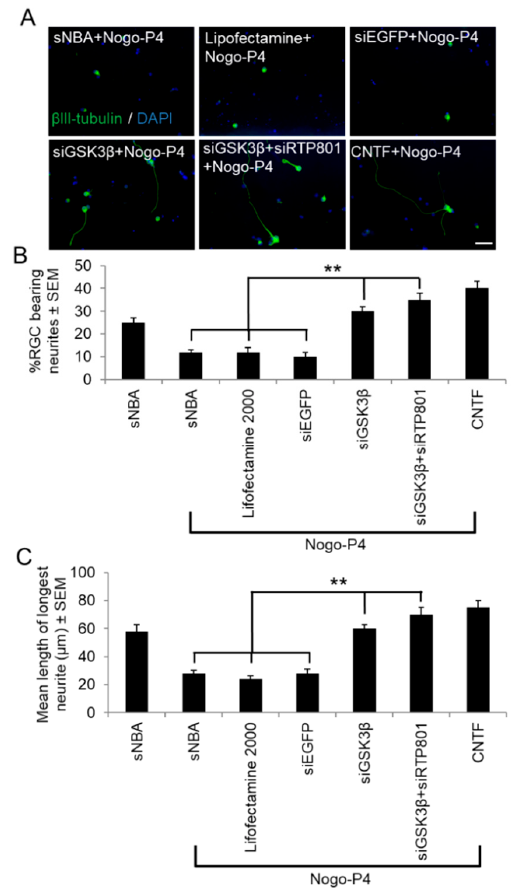
Figure 6. Inhibition of GSK3 β activity promotes disinhibition of RGC neurite outgrowth in the presence of inhibitory Nogo-P4 peptide. ( A ) Immunocytochemistry showing disinhibited neurite outgrowth from β III-tubulin + RGC in the presence of Nogo-P4 peptide after treatment with siGSK3 β whilst control cultures treated with sNBA, Lipofectamine 2000, or siEGFP were unable to achieve disinhibited neurite outgrowth. CNTF-treated cultures were used as positive controls. ( B ) Quantification of the proportion of RGC bearing neurites and ( C ) the mean longest RGC neurite after siRNA treatment in the presence of Nogo-P4 peptide, showing significant disinhibition of neurite outgrowth after treatment with siGSK3 β . (Scale bar in A = 20 µ m; ** = p < 0.01). n = 2 wells / treatment, 3 independent repeats (total n = 6 wells/treatment).